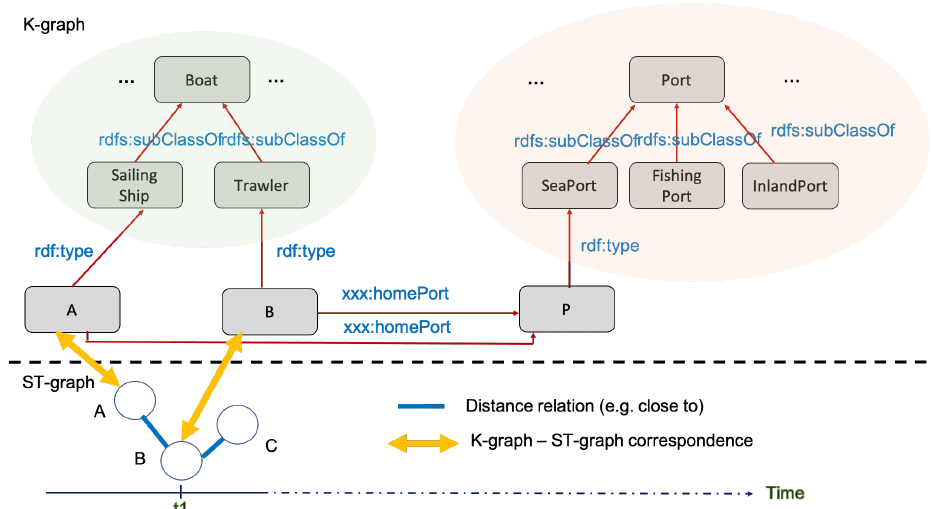
Figure 11. Potential correspondence between K-graph and ST-graph (one